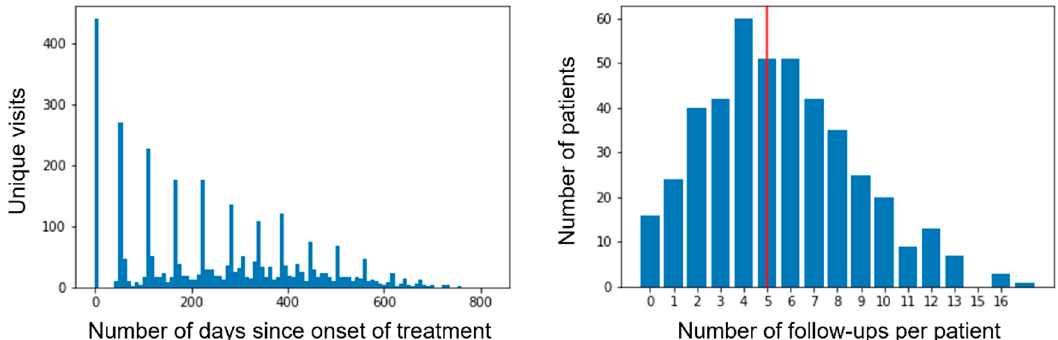
Figure 1. Number of unique visits over time ( left ) and number of follow-up visits per patient; red line indicates the mean number of visits ( right